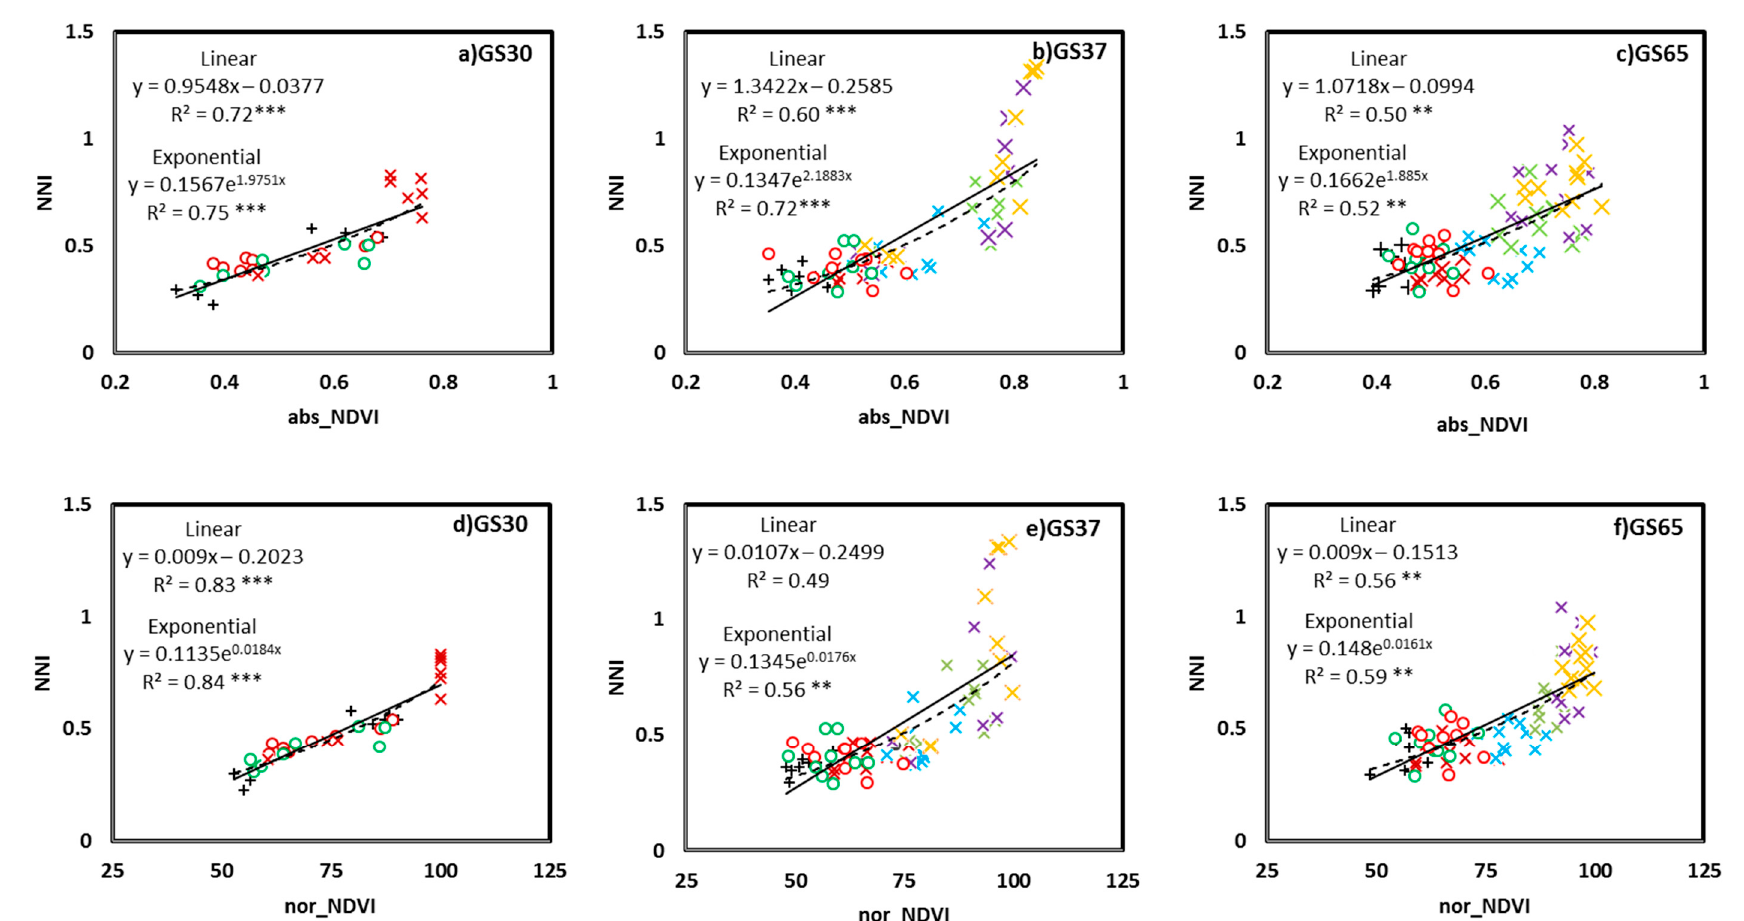
Figure 2. Relationship between the NNI (Nitrogen Nutritional Index) and abs_NDVI values at GS30 ( a ), GS37 ( b ), and GS65 ( c ) and between the NNI and nor_NDVI values at GS30 ( d ), GS37 ( e ), and GS65 ( f ). Two models were fitted: linear, solid line; exponential, dashed line. **, *** Significant at 0.01 and 0.001 probability levels, respectively. + , 0N; × , 40N + 0N; × , 40N + 40N; × , 40N + 80N; × , 40N + 120N; × , 40N + 160N; o, DS + 0N; o, SM + 0N. abs, absolute values; nor, normalized values; NDVI, Normalized Difference Vegetation Index.